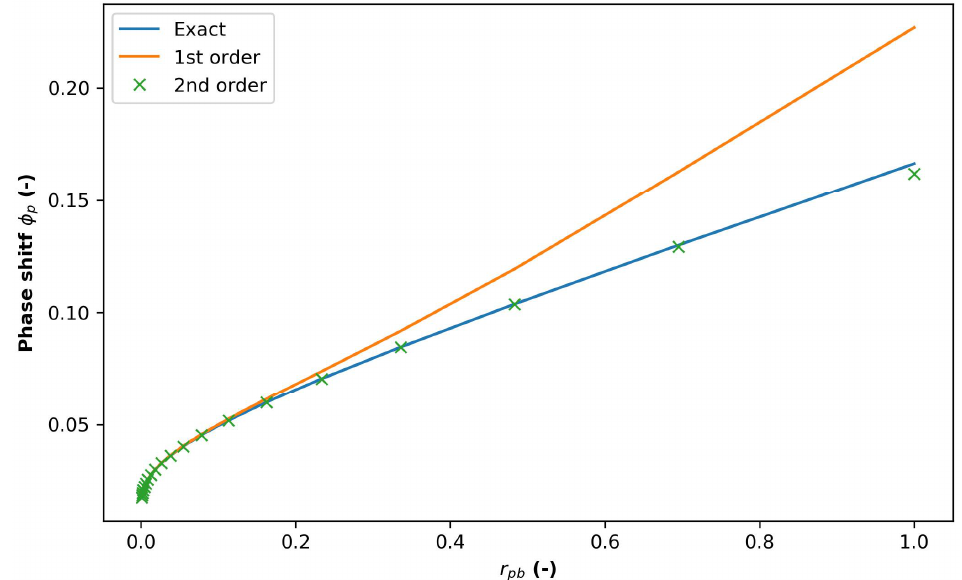
Figure A2. Comparison of the Taylor series expansion of the Kelvin funcion (blue line) with first-